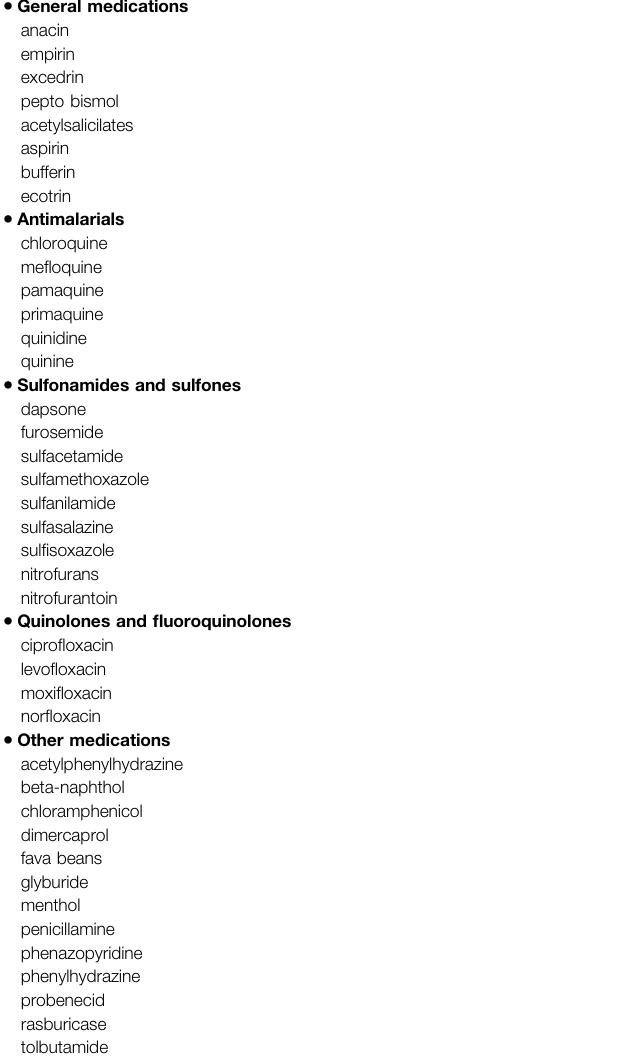
TABLE 1 | Drugs to be Avoided in Patients with Glucose-6-Phosphate Dehydrogenase De fi ciency. (cid:129) General